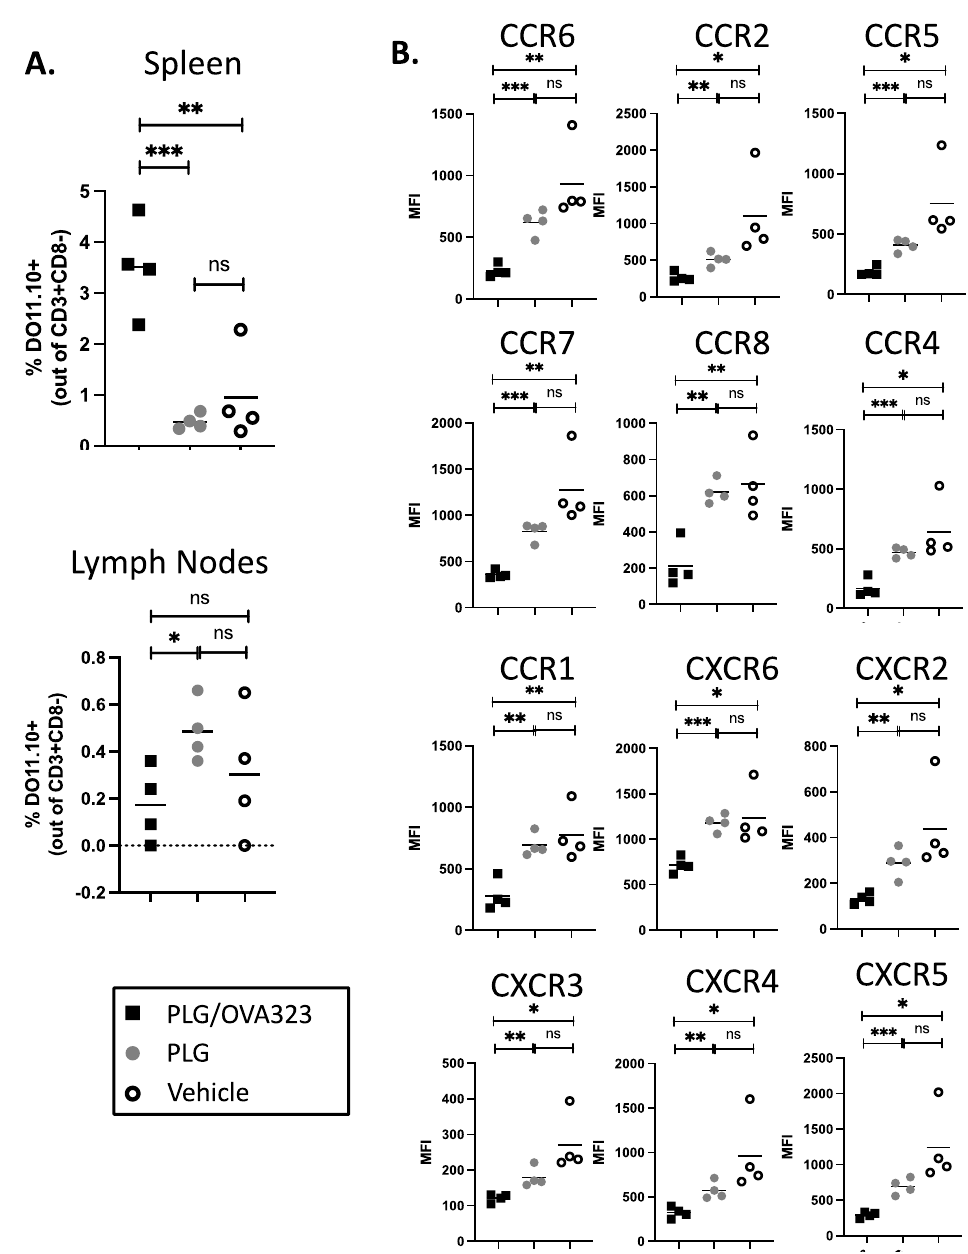
Figure 7. Antigen-loaded nanoparticles induce sequestration of transgenic CD4 + T cells in secondary lymphoid tissues and alter expression of chemokine receptors. Spleens were harvested from DO11.10 transgenic mice ( n = 2–3) and CD4 + T cells were isolated by magnetic cell separation, then transferred to recipient BALB/C mice. Three days after cell transfer, mice were treated daily for 5 consecutive days with PLG/OVA323 or PLG. The numbers of DO11.10 T cells were determined in spleens or pooled inguinal, axillary, and brachial lymph nodes harvested 24 h after the final treatment. Statistical significance was determined by Student’s t -test. ns not significant, * p < 0.05, ** p < 0.01, *** p < 0.001. ( A ) Cell frequencies were determined by flow cytometry. ( B ) Levels of chemokine receptor expression on spleen-sequestered cells were determined by geometric mean fluorescence intensity.